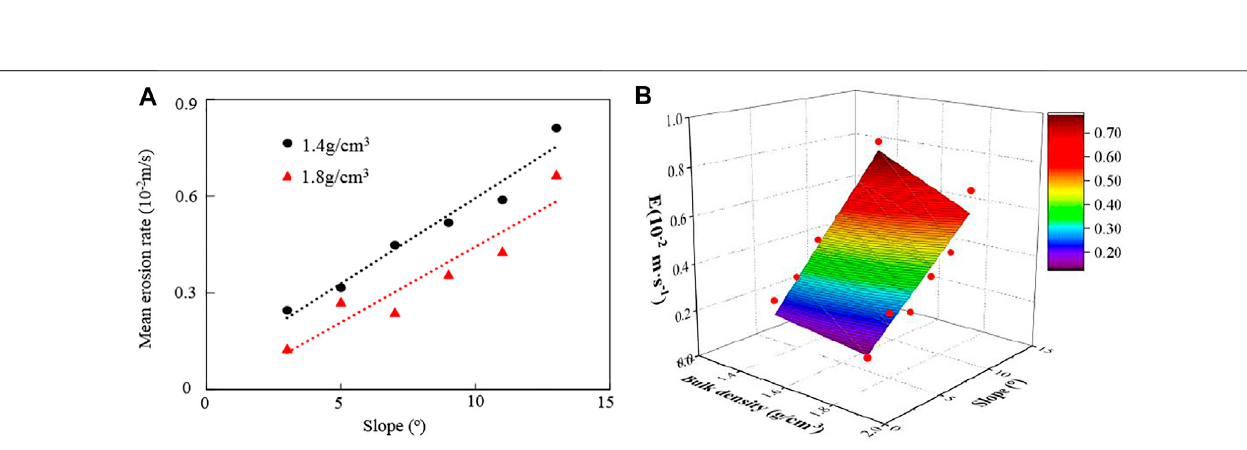
FIGURE14 | Relationships ofthe erosion rate with slope and bulk density: (A) relationship between the average erosion rate and slope with different values of bulk density, and (B) a multivariate nonlinear regression curve.